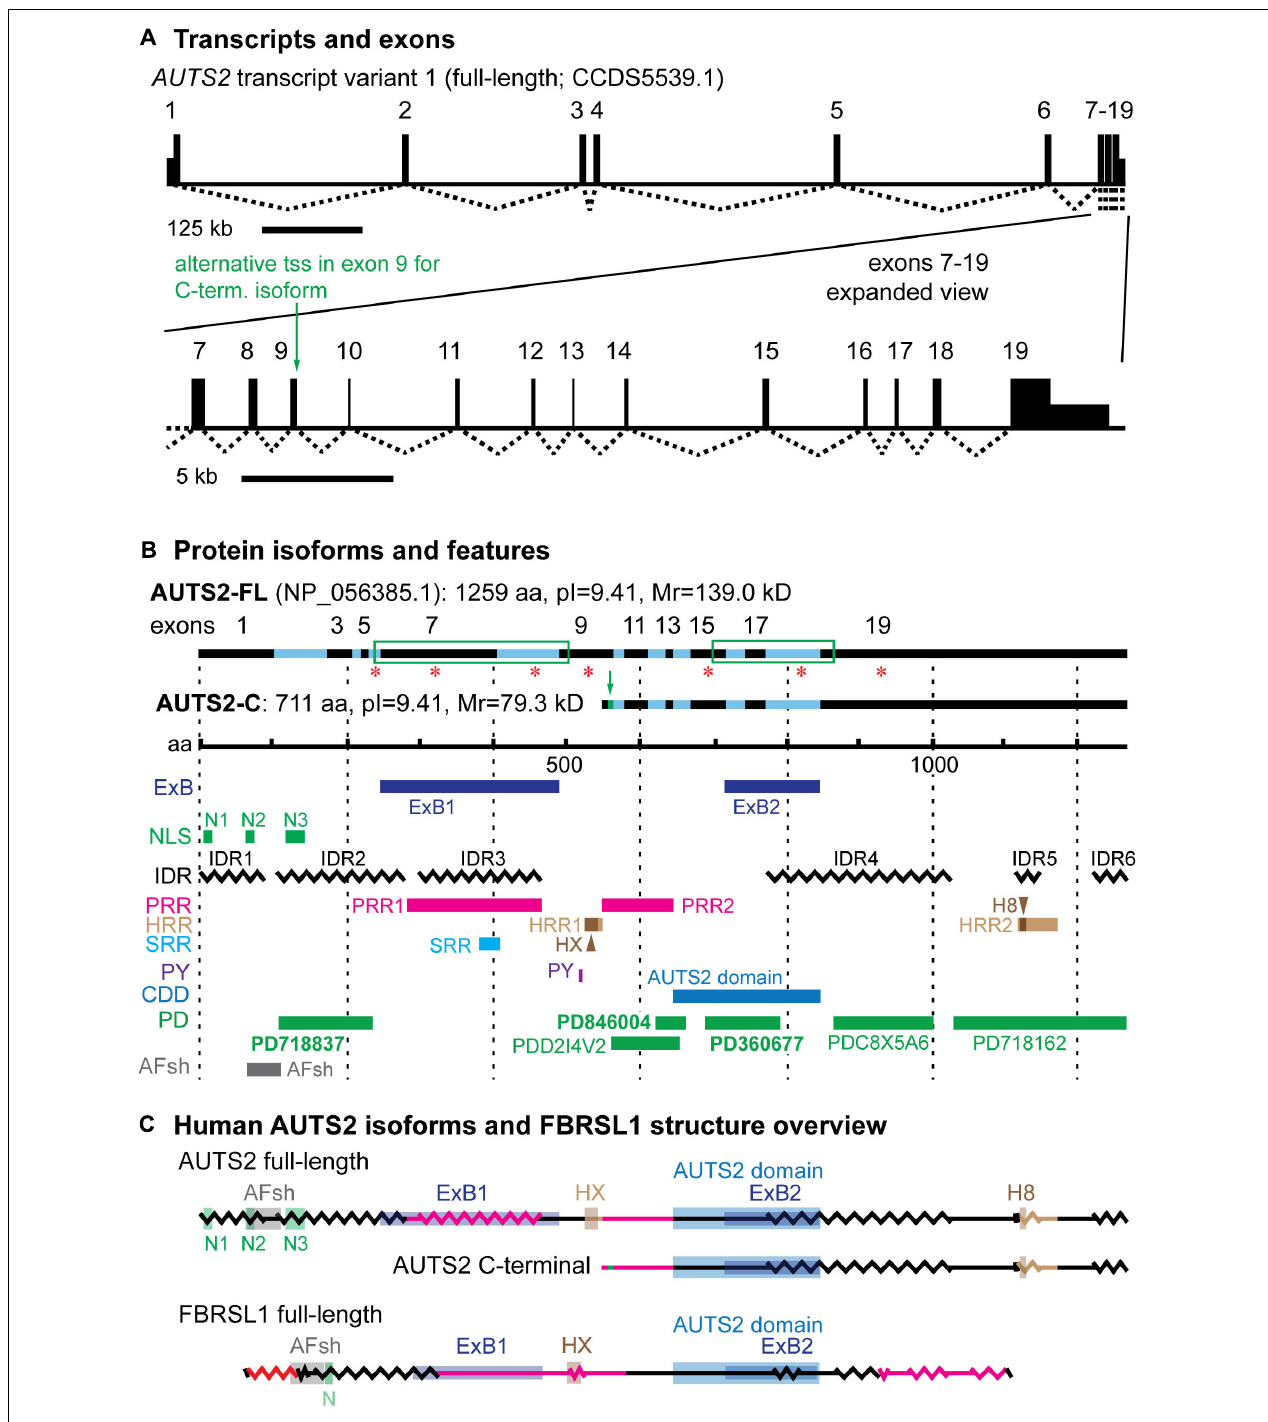
FIGURE 1 | AUTS2 transcripts and protein isoforms. (A) The full-length AUTS2 transcript has 19 exons. An alternative transcription start site (tss) in exon 9 produces mRNA for the C-terminal protein isoform. (B) The full-length and C-terminal isoforms are indicated with source exons in black (odd) and blue (even). Green boxes enclose splice junctions in which amino acids were encoded across the junctions, comprising exon blocs. Red asterisks indicate source exons that encoded a non-integer number of amino acids. Features mapped from protein sequence: ExB, exon bloc; NLS, nuclear localization sequence; IDR, intrinsically disordered region; PRR, Pro-rich repeat; HRR, His-rich repeat; HX, HX repeat; H8, polyhistidine (8 × ) repeat; SRR, Ser-rich repeat; PY, PY protein binding motif; CDD, conserved domain database; PD, ProDom predicted domains (domain names in bold also identified in FBRSL1); AFsh, AUTS2-FBRSL1 short homology region. (C) Both major AUTS2 isoforms have a high content of IDRs (zigzag lines) and regions enriched in amino acids Pro, His, or Ser (red lines). The C-terminal isoform includes the AUTS2 domain, but lacks N-terminal features such as the HX repeat.